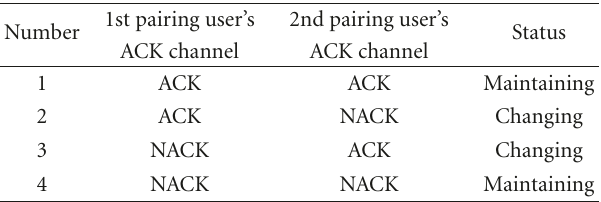
Table 1: Event status for indicating the authority of a shared RB. 1st pairing Number